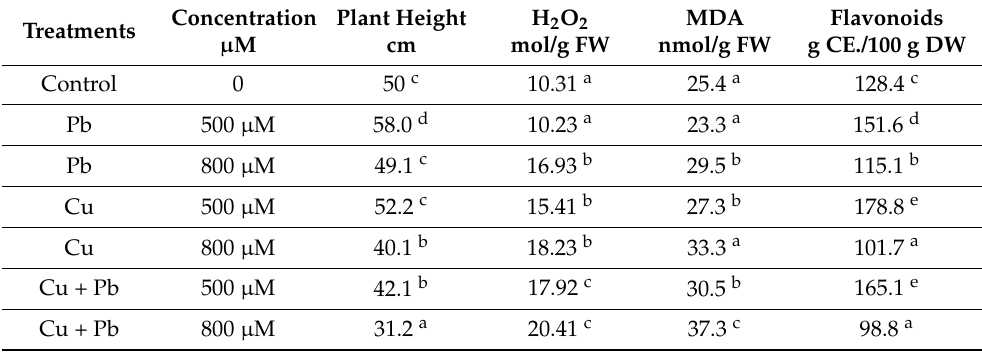
Table 1. Effects of Cu(SO 4 ) 2 and Pb(NO 3 ) 2 on plant height (cm), H 2 O 2 (mol/g FW) malondialdehyde (MDA) (nmol/g FW) and flavonoids (g CE./100 g DW) of Citrus aurantium L. plants. The